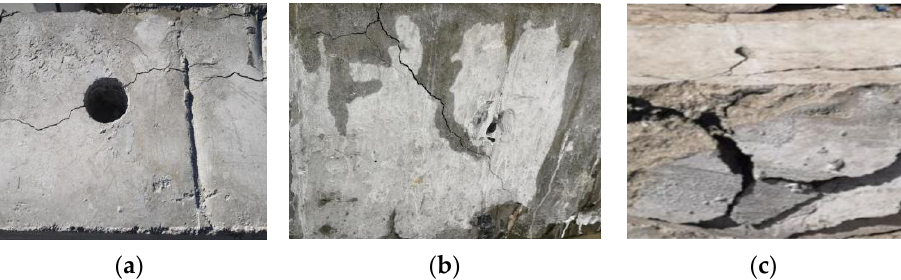
Figure 7. Breaking effect of Hole 2. ( a ) First discharge; ( b ) Fourth discharge; ( c ) Tenth discharge.